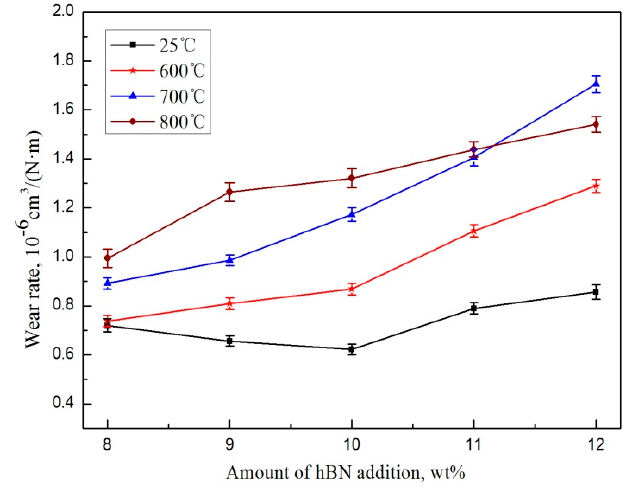
Figure 6. Influence of hBN content on the wear rate of NiCr/hBN composite at different friction temperatures.